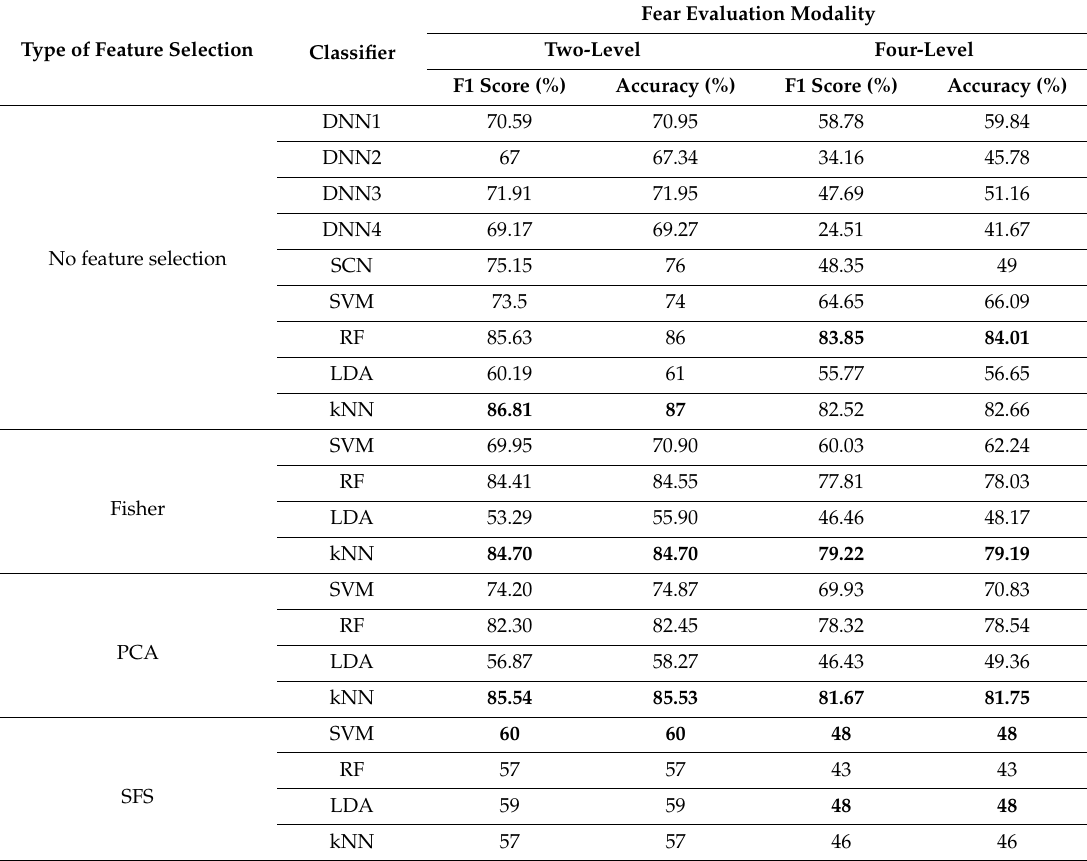
Table 3. Classification accuracy when input is a vector of 32 raw electroencephalograms (EEGs) and eight peripheral signals. (The highest accuracies are written with